Question: Describe this figure in one sentence.
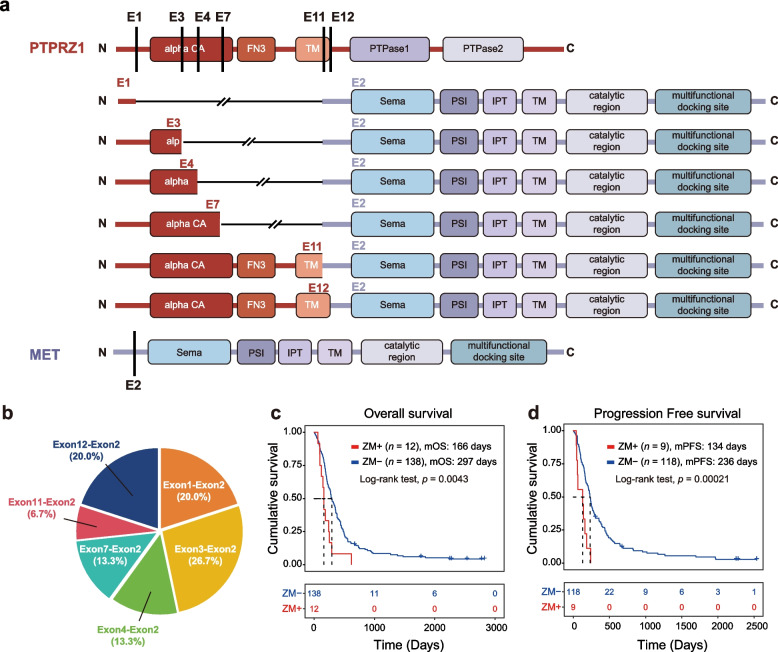
Answer: Landscape of PTPRZ1-MET (ZM) fusion variants and clinical outcomes in secondary glioblastoma (sGBM). a Schematic representation of the six identified PTPRZ1-MET fusion variants. PTPRZ1-derived regions are shown in red and MET-derived regions are shown in blue/purple. The schematic shows PTPRZ1 breakpoints at exons 1, 3, 4, 7, 11, and 12, all fused to MET exon 2. Protein domains are labeled, including alpha carbonic anhydrase-like domain (alpha CA), fibronectin type III domain (FN3), transmembrane domain (TM), PTPase domains, Sema domain, PSI domain, IPT domain, catalytic region, and multifunctional docking site. b Distribution of the six ZM fusion subtypes in the cohort. Different colors indicate different fusion subtypes, and percentages indicate the proportion of each subtype among ZM-positive tumors, including exon 3–exon 2 (26.7%), exon 1–exon 2 (20.0%), exon 12–exon 2 (20.0%), exon 7–exon 2 (13.3%), exon 4–exon 2 (13.3%), and exon 11–exon 2 (6.7%). c Kaplan–Meier overall survival curves comparing ZM-positive and ZM-negative patients. Red and blue curves represent ZM-positive and ZM-negative patients, respectively. The number-at-risk table below the plot shows the number of patients remaining at risk at each time point. Statistical significance was assessed using the log-rank test ( p = 0.0043). d Kaplan–Meier progression-free survival curves comparing ZM-positive and ZM-negative patients. Red and blue curves represent ZM-positive and ZM-negative patients, respectively. The number-at-risk table below the plot shows the number of patients remaining at risk at each time point. Statistical significance was assessed using the log-rank test ( p = 0.00021)